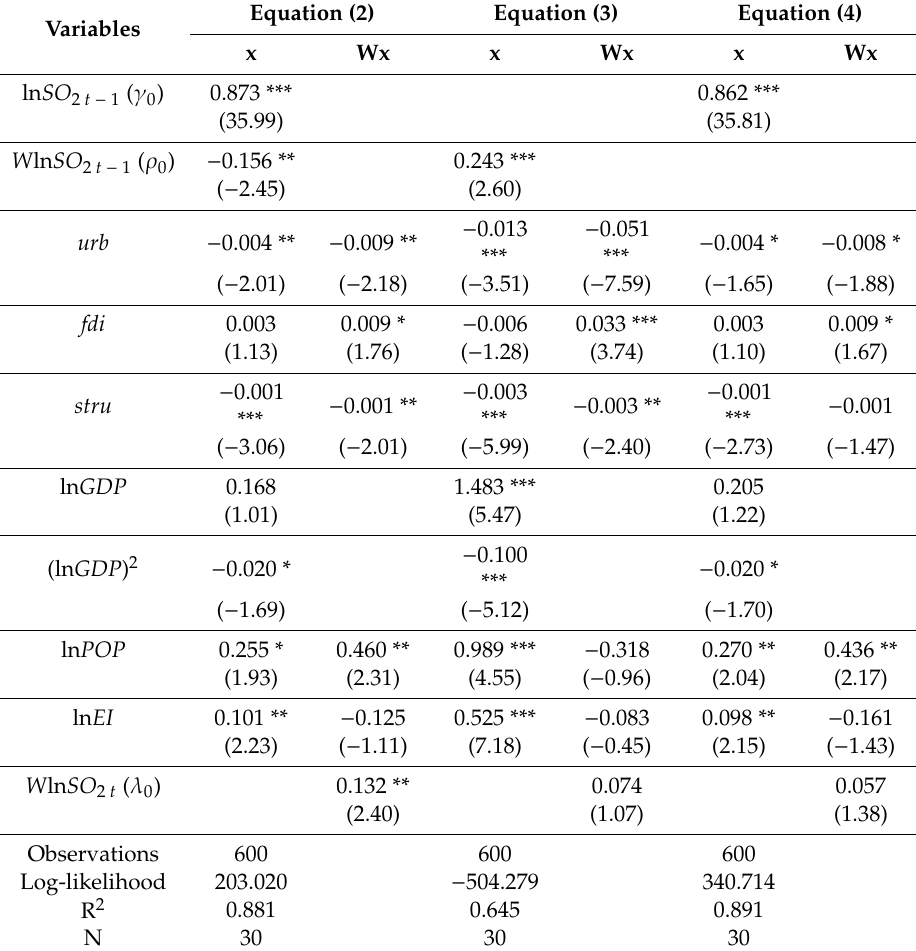
Table 4. Coe ffi cients estimates of the dynamic spatial Durbin models.